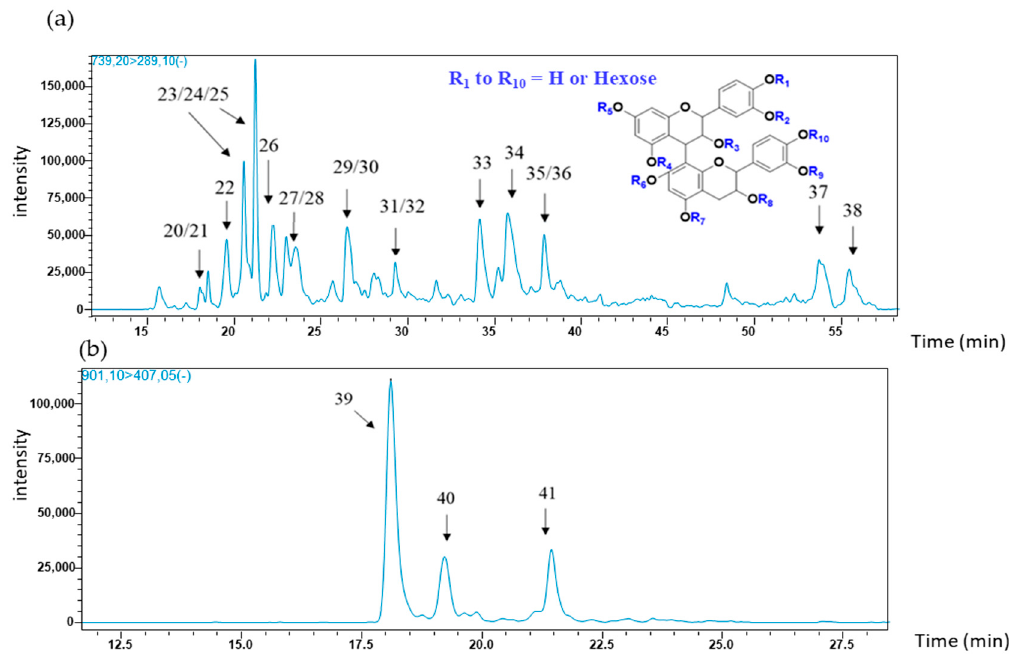
Figure 2. MRM profiles from the UHPLC-MS analysis of ( a ) (epi) catechin dimer glycosides {739 → 289} and ( b ) (epi) catechin dimer diglycosides {901 → 407} of a grape seed extract (Tannat, 25 July).